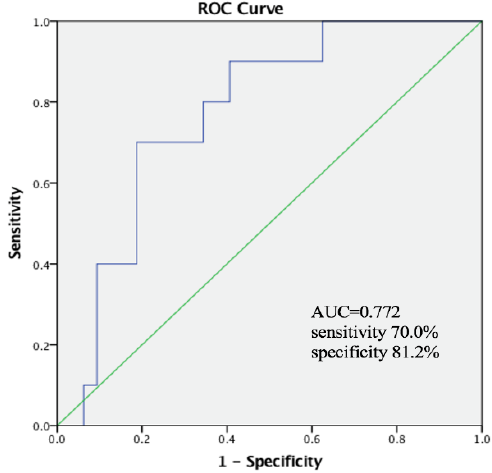
Figure 3. Receiver-operating curve analysis for phase angle (PhA) to diagnose malnutrition in females according to the GLIM criteria with optimal PhA level cut-off of 5.55°.